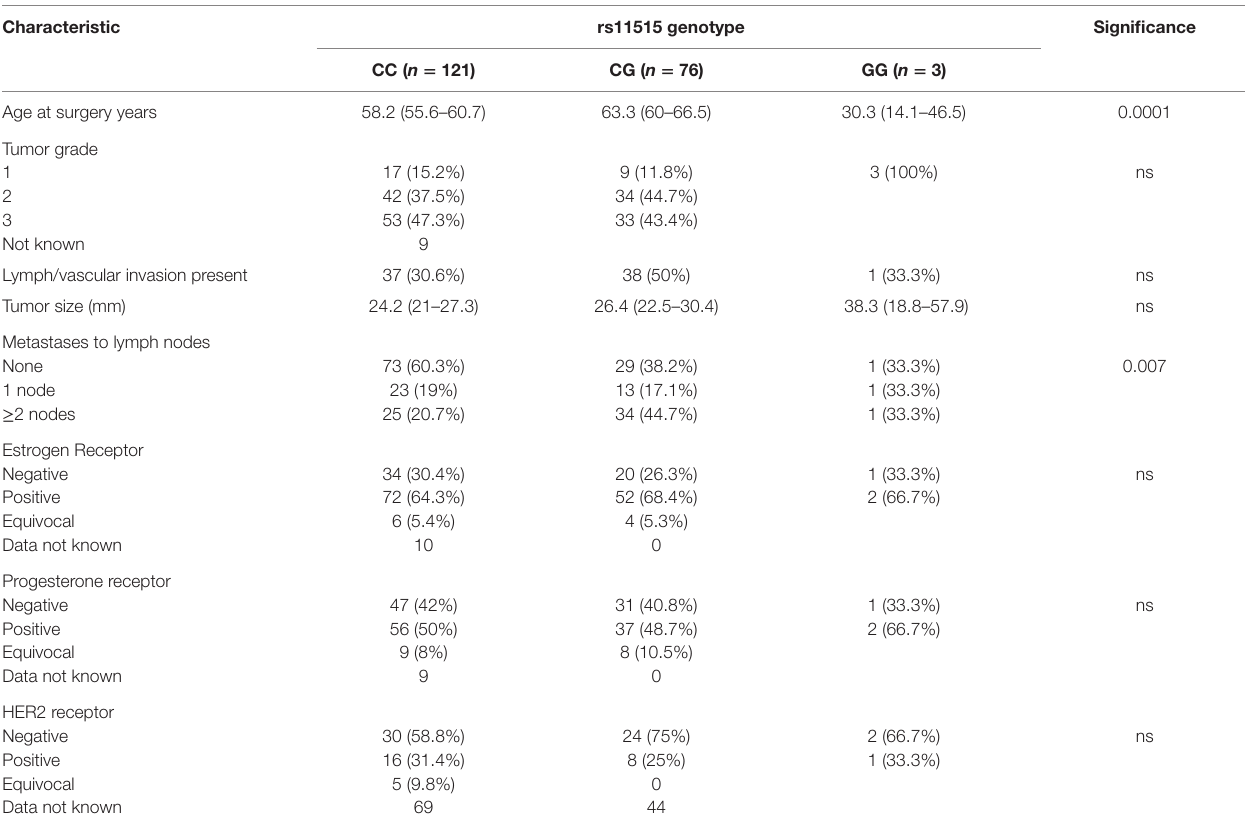
TaBle 1 | characteristics of the 200 women with breast cancer relative to their rs11515